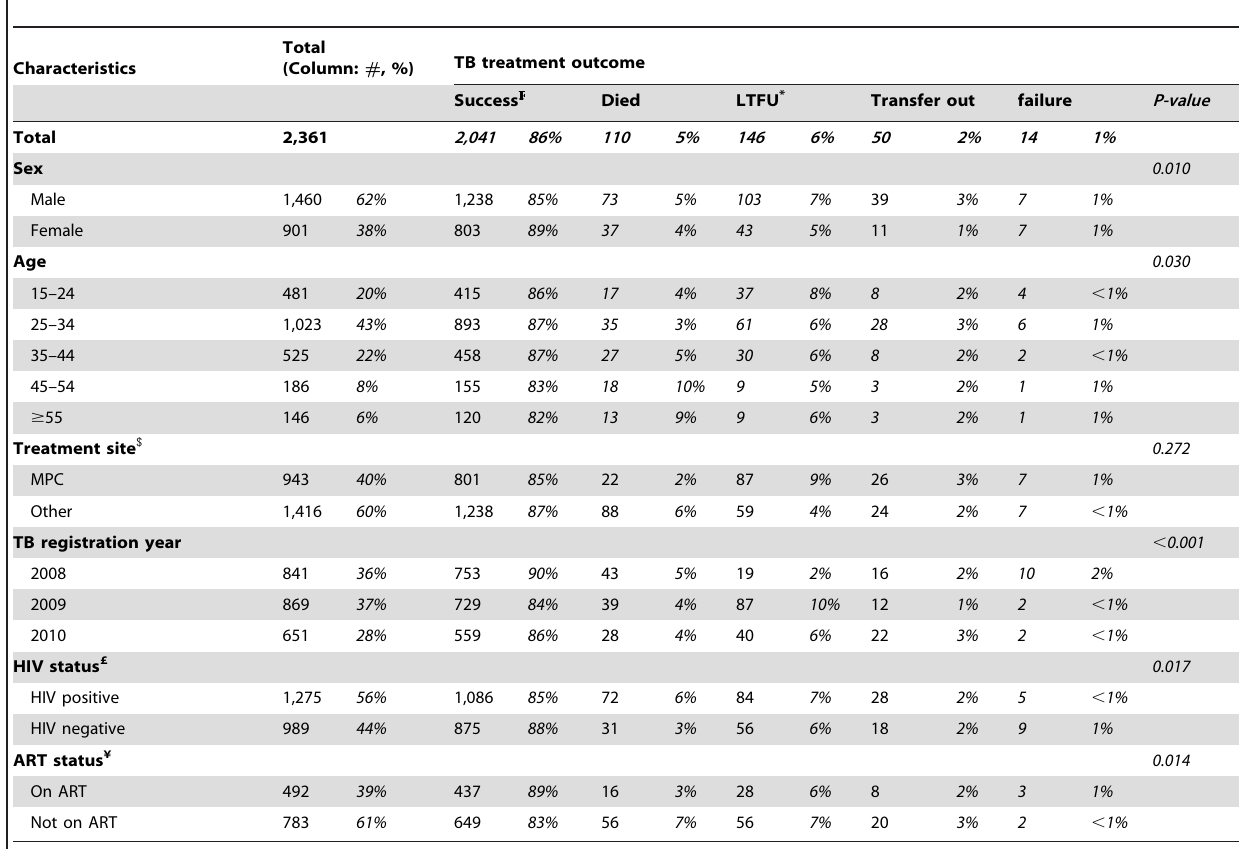
Table 1. Patient characteristics by TB treatment outcomes for new smear-positive TB patients at Martin Preuss Centre between January 2008 and December